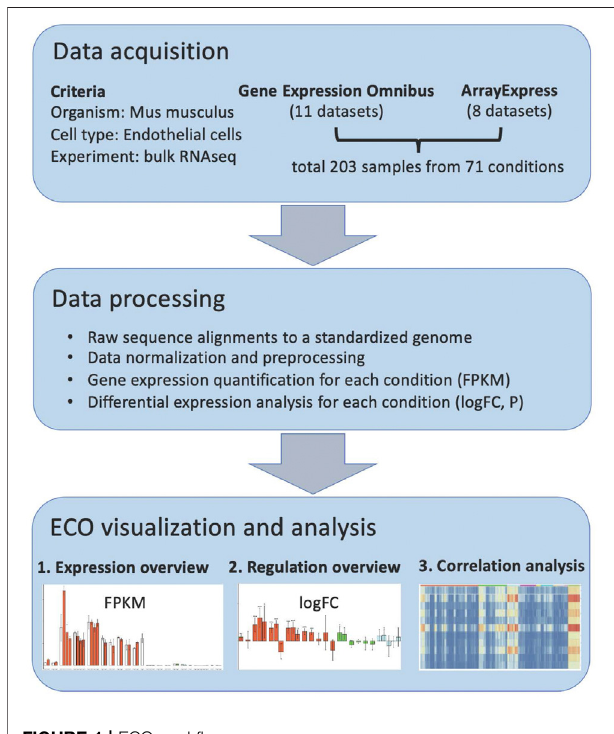
FIGURE 1 | ECO work fl